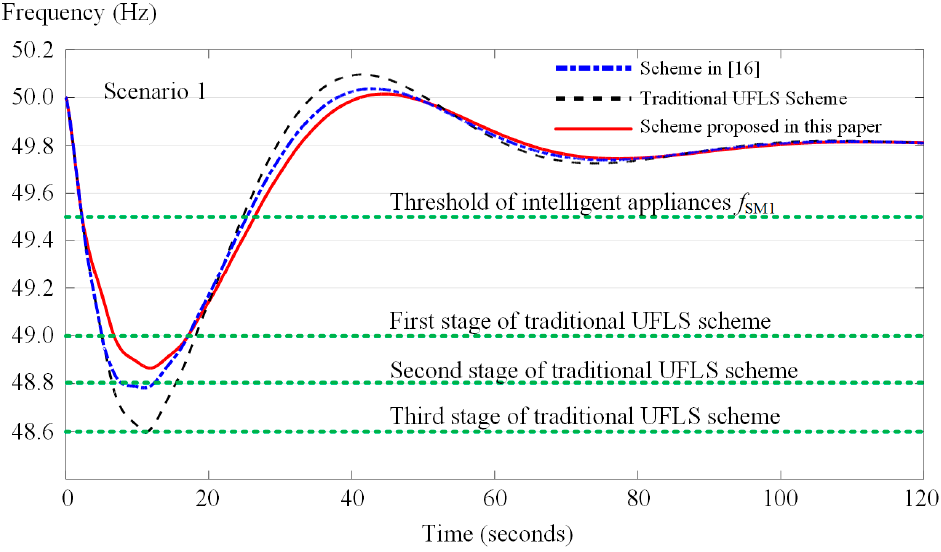
Figure 8. Curves of frequency in Scenario 1 under the three comparison schemes.